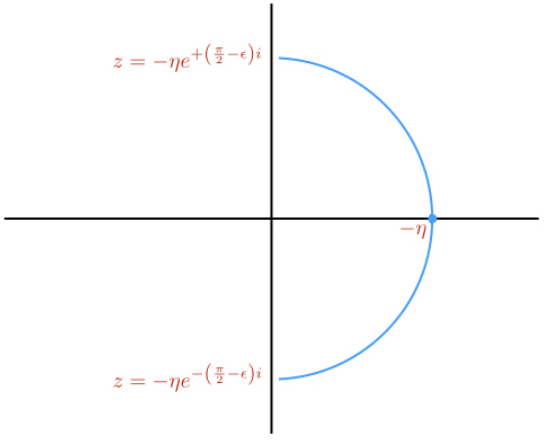
Figure 1. Analytic continuation from EAdS to